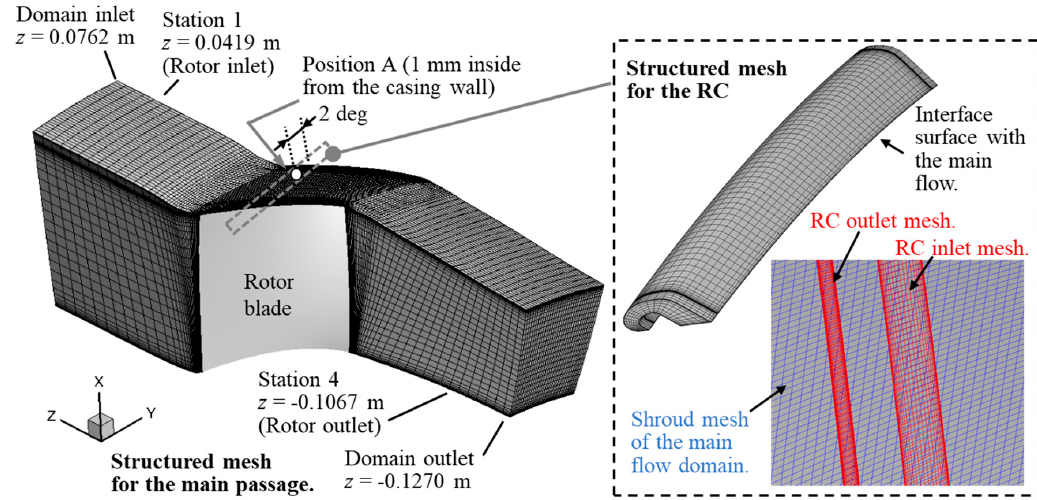
Figure 4. NASA Rotor 37 passage computational domain and mesh with circumferential recirculation channel.